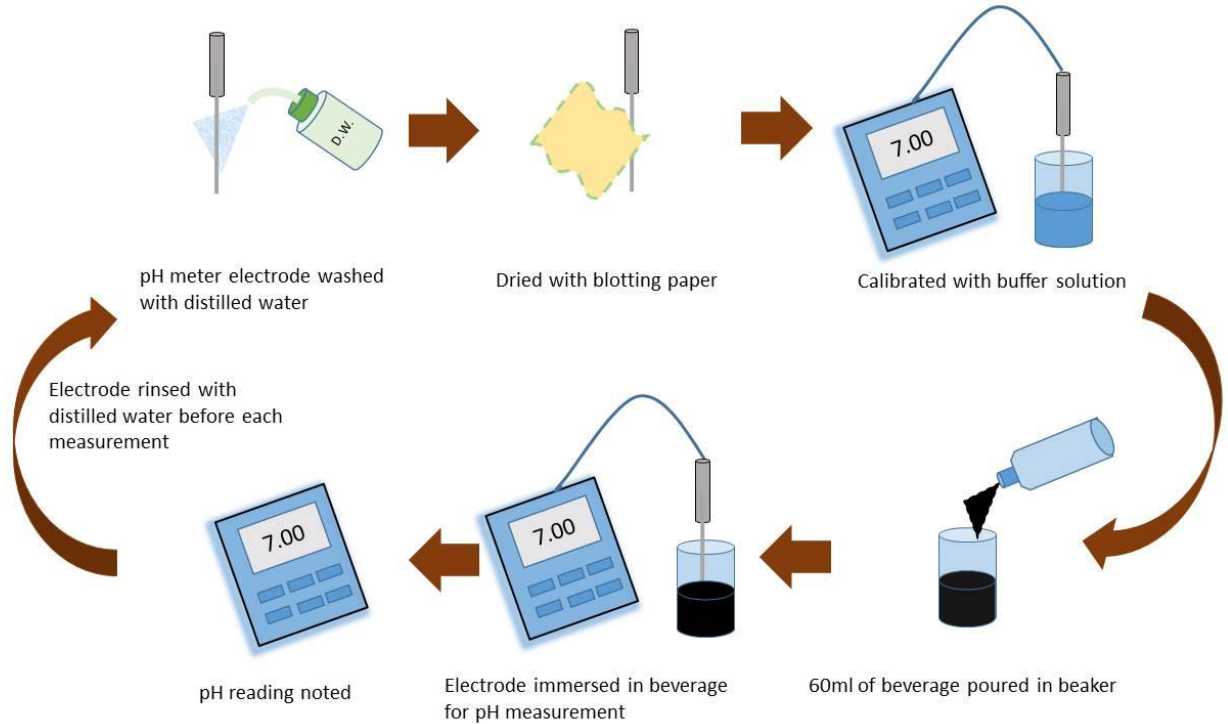
Figure 1. Schematic representation showing the procedure for pH measurement. Based on pH measurements, five highly acidic beverages (L1 = Red Bull, L2 = Pepsi, L3 = Apple Cidra, L4 = Tang Mosambi and L5 = Tang Orange) were selected for further evaluation regarding their effects on tooth structure loss and surface hardness.